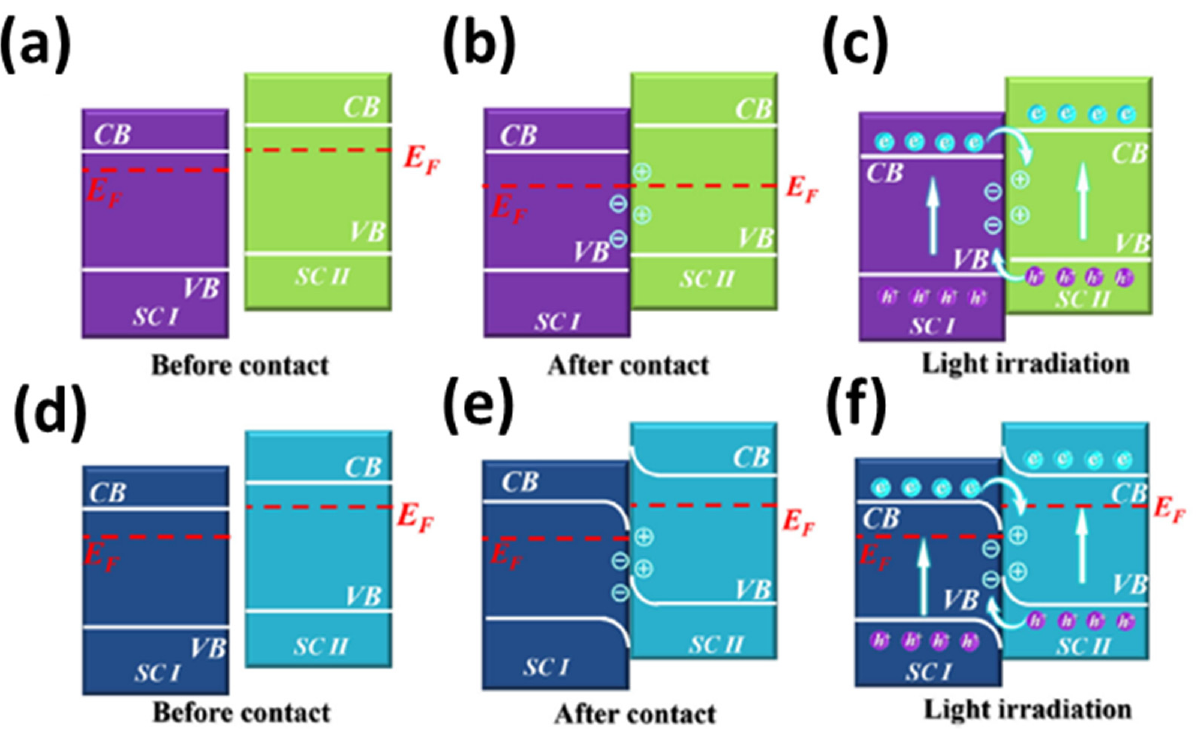
Figure 7. ( a – c ) Z-scheme and ( d – f ) S-scheme photocatalytic systems. Reprinted with permission from Ref. [136]. Copyright 2022 John Wiley and Sons.